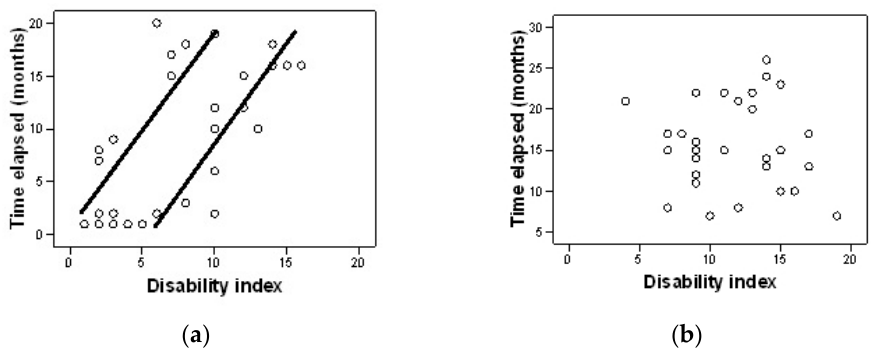
Figure 2. Correlation between the time elapsed from diagnosis and the disability index after six months for the experimental group ( a ) and control group ( b ). months for the experimental group ( a ) and control group ( b